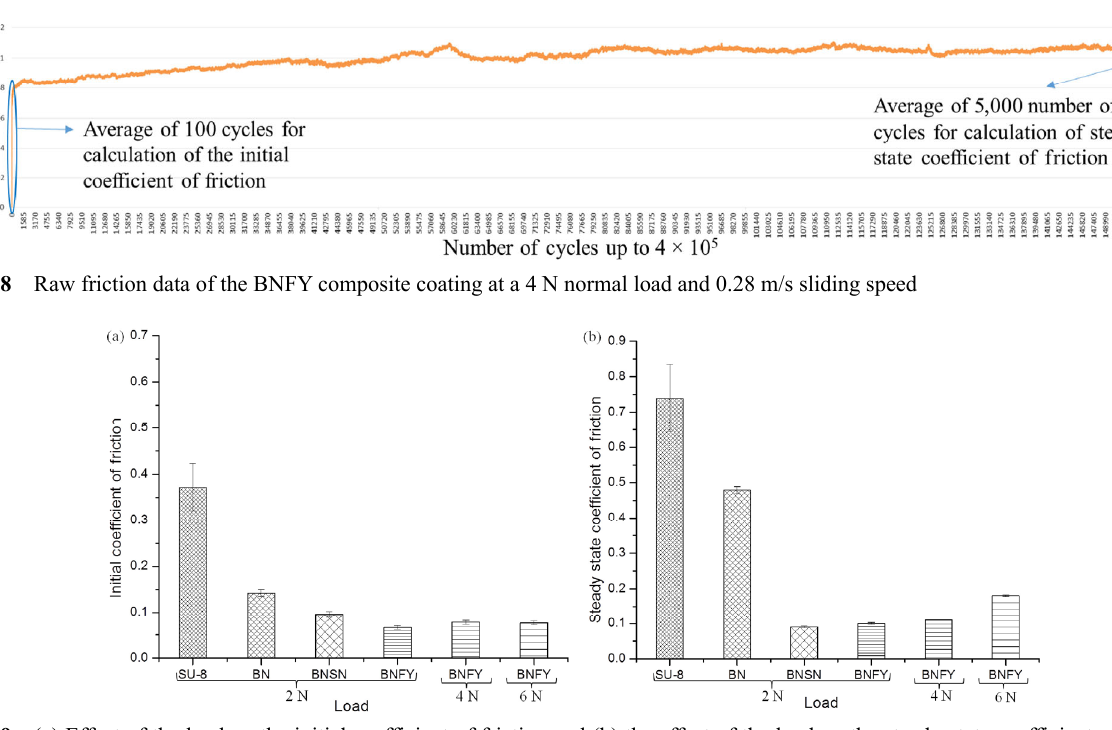
Fig. 9 (a) Effect of the load on the initial coefficient of friction and (b) the effect of the load on the steady-state coefficient of friction for SU-8 and its composites. The error bars in (a) and (b) show the standard errors of three repetitions for each data